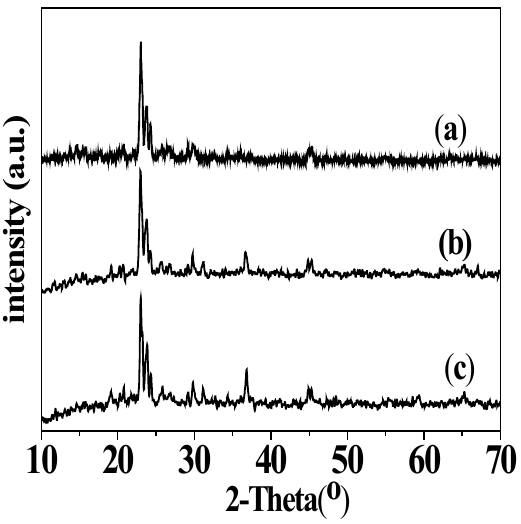
Figure 1: XRD patterns of samples (a) ZSM-5, (b) Co/ZSM-5 and (c) C mimHSO -Co/ZSM-5. 7 4